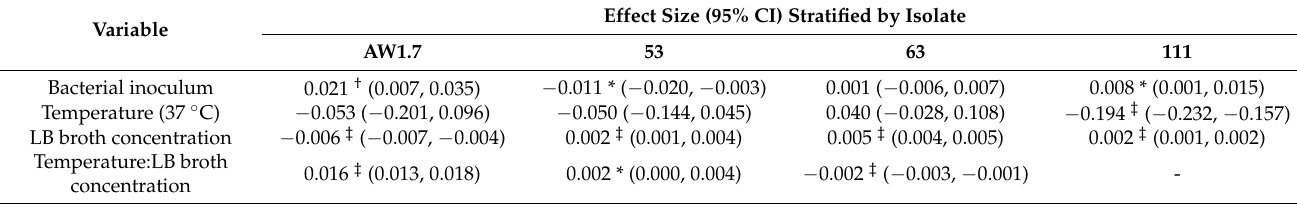
Table 3. Genetic determination of biofilm formation-associated genes in heat resistant Escherichia coli.